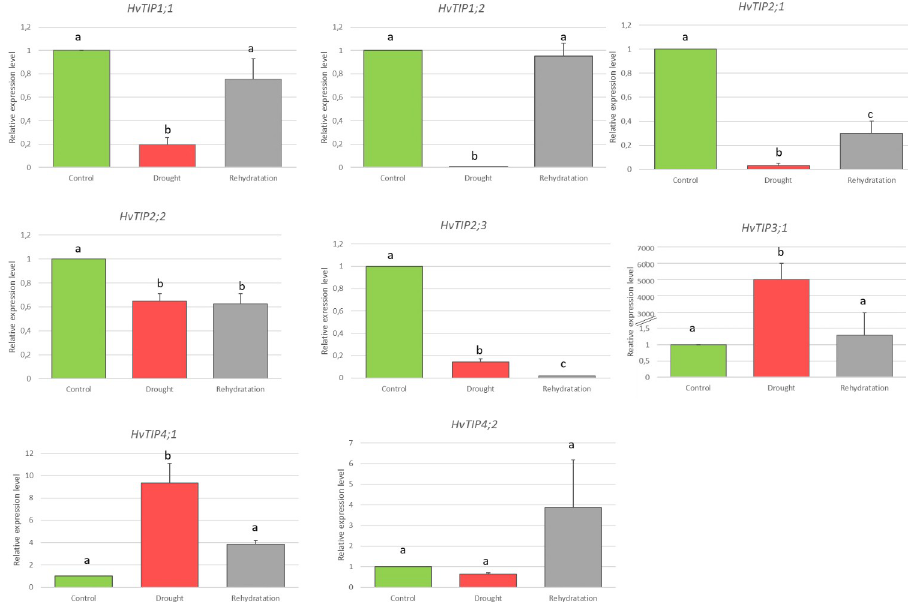
Fig 7. Expression patterns of HvTIP genes under drought stress and re-watering in barley leaves. Relative expression level was evaluated in comparison to control plants which were grown under optimal soil moisture. The statistical analysis was performed using the one-way ANOVA followed by Fisher Least Significant Difference (LSD). Statistically significant differences (P < 0.05) are marked by different letters.